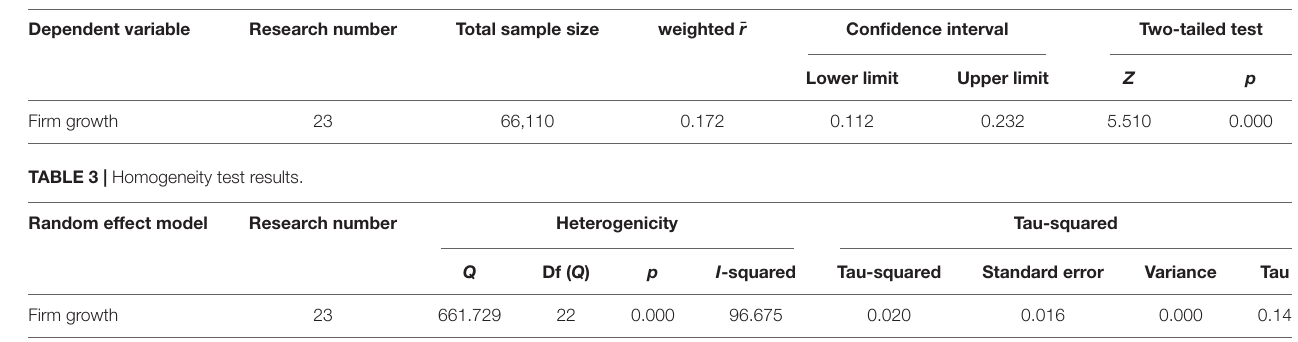
FIGURE 2 | Funnel diagram of publication bias. TABLE 2 | Analysis of imitation strategy and firm growth.